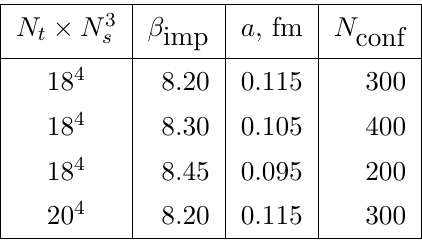
Table 1 . The parameters and number of the lattice con(cid:12)gurations used for the simulations. creates a kind of anisotropy in space, which can lead to tensor polarization (alignment) of the vector meson and, after its decay, to dileptonic asymmetry in collisions of heavy ions. Dilepton anisotropy [24] is an important physical characteristic which is sensitive to dif- ferent channels of particle’s decay and can be utilized to disentangle contributions of some channels. Dilepton asymmetries provide information about the evolution of quark-gluon plasma in non-central heavy-ion collisions [25]. Here we study the in(cid:13)uence of